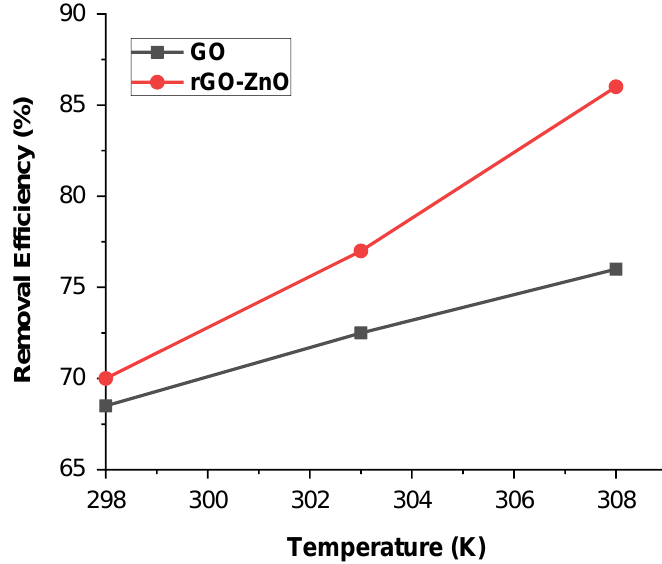
Figure 7. % Removal of Cr (VI) by adsorbents at various temperatures.